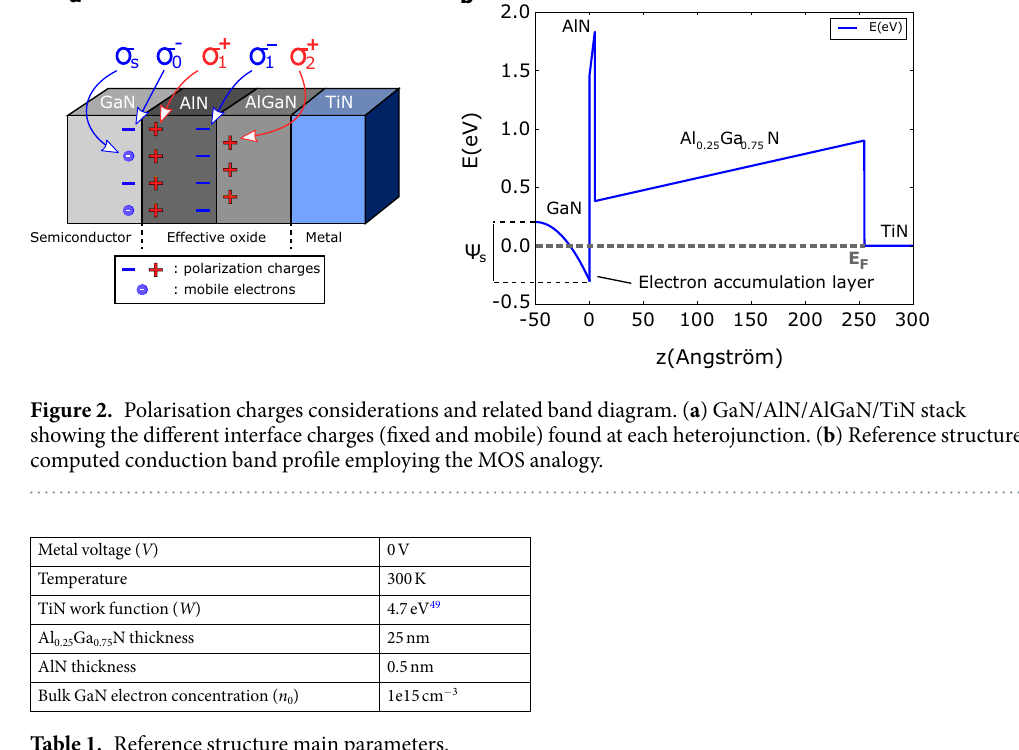
Table 1. Reference structure main